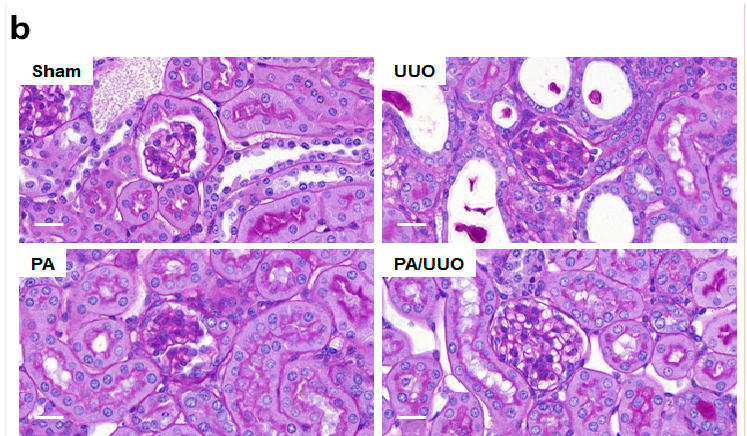
Figure 1. The effects of pomolic acid (PA) on histological alterations in unilateral ureteral obstruction (UUO) mice. Histopathological alterations in the hematoxylin and eosin (H&E)-stained ( a ) and the periodic acid–Schiff (PAS)-stained slides ( b ). H&E: Scale bar 50 μ m. PAS: Scale bar 20 μ m.